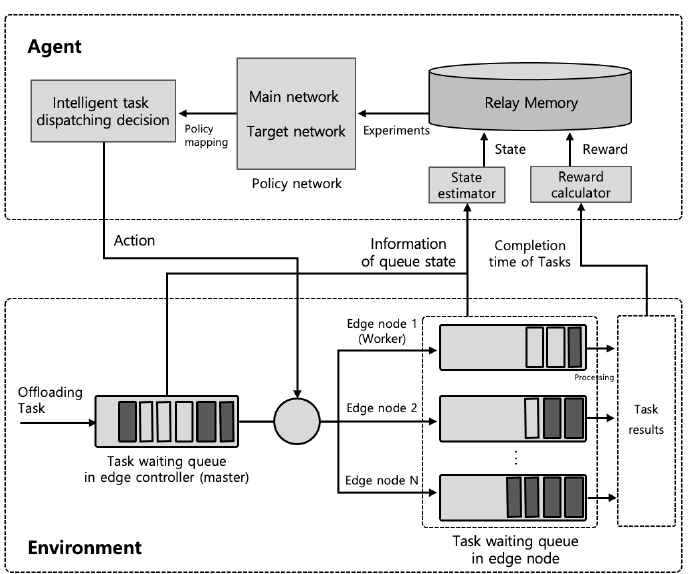
Figure 3. Illustration of the proposed DQN for task dispatching